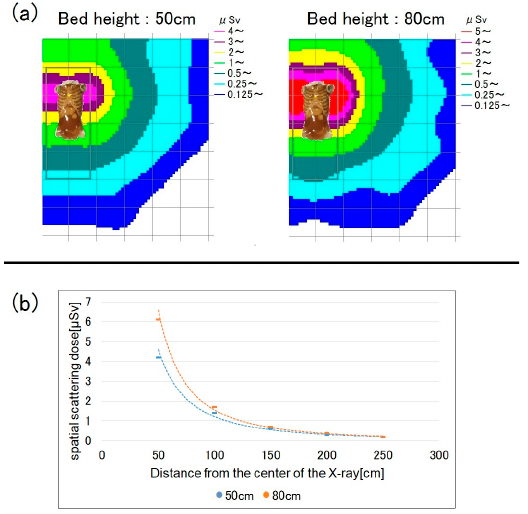
Figure 3. Spatial scattered radiation dose by bed height (50 vs. 80 cm) at a measurement height of 150 cm. ( a ) Dose-distribution map and ( b ) graph showing the spatial doses. When the bed height was 80 cm, the scattered dose was higher, although the difference became smaller as the distance from the X-ray center increased. Figure 5 shows the radiation doses for chest radiography at a bed height of 50 cm. For low measurement points, the spatial dose tended to be higher. Figure 6 shows the doses for a bed height of 80 cm; at this bed height, there were no significant differences in dose between measurement points. Figure 7 shows the spatial doses for chest and abdominal imaging at a bed height of 80 cm and measurement height of 150 cm. For abdominal radiography, the dose was about three- to four-fold higher than for chest radiography. We compared the spatial dose between X-ray field sizes of 14 × 14 and 14 × 17 inches, with the latter dimension (17 inches) of both fields being in the cranio-caudal direction. The larger field increased the spatial dose by about 20% (Figure 8). Table 1 summarizes our study results. There were very few uncertainties in our study data, so the standard deviations were near zero.